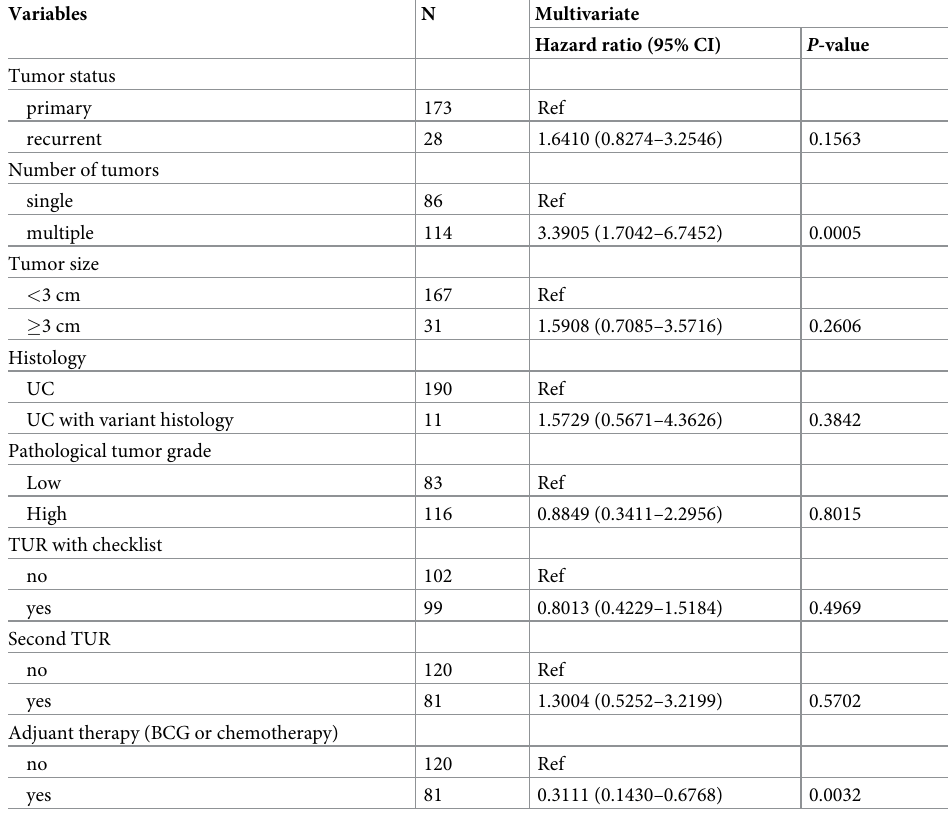
Table 2. Multivariate analysis with Cox proportional hazards modeling for intravesical recurrence.